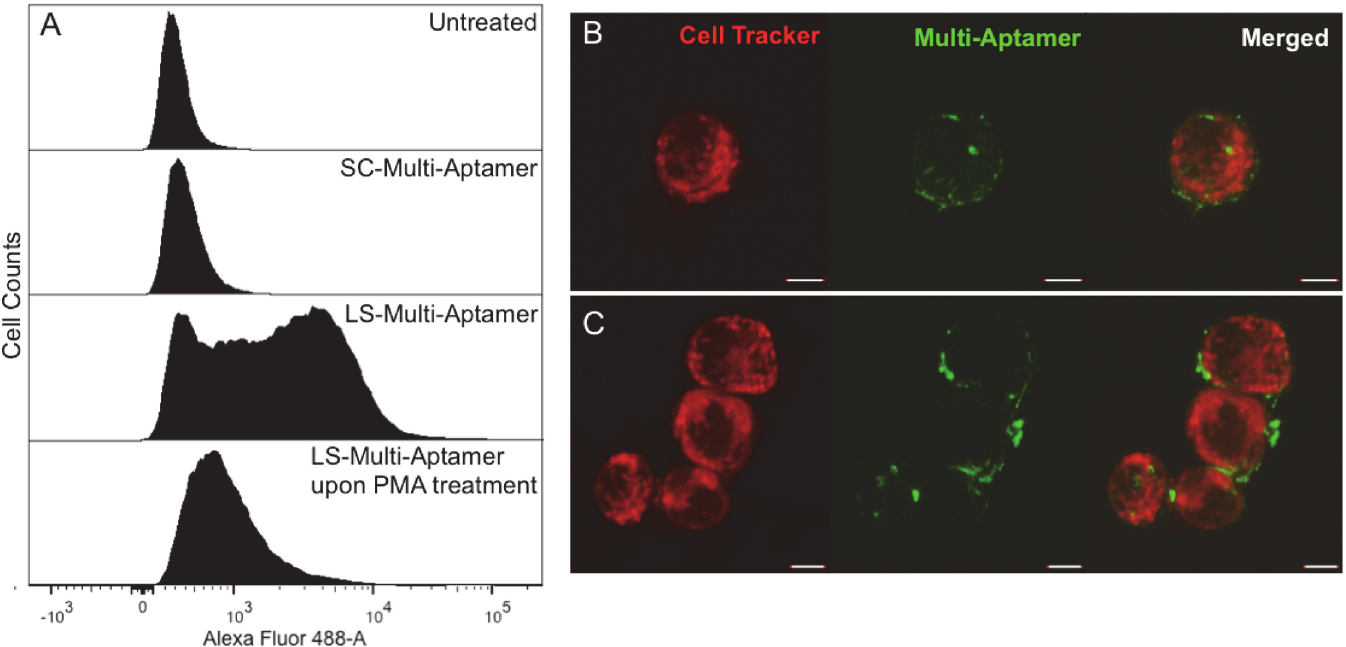
Fig 3. LS-Multi-Aptamer specifically binds to L-selectin on Jurkat cells. (A) Flow cytometry histograms of Jurkat cells stained with the indicated Multi- Aptamers and controls. (B) Confocal microscope images demonstrate that FITC-labeled LS-Multi-Aptamer (green) effectively binds to Jurkat cells (red). (C) Confocal microscope images demonstrate that cross-linking of multiple Jurkat cells by the LS-Multi-Aptamer can be occasionally found. Scale bar is 5 μ m.